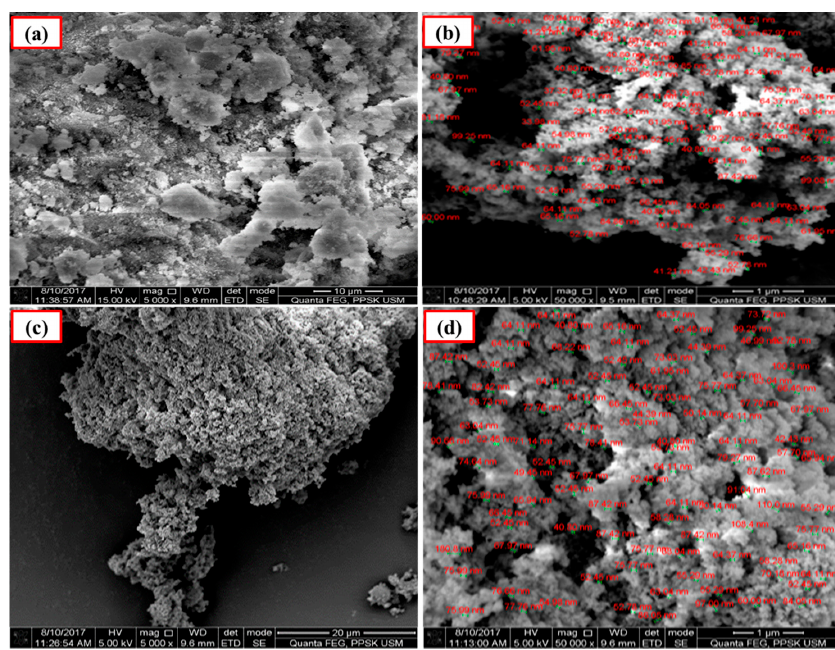
Figure 3. SEM images of calcia-stabilized zirconia (Ca-SZ) pellets before sintering. ( a , b ): CaO derived from cockle shells; ( c , d ): commercial nano-CaO.